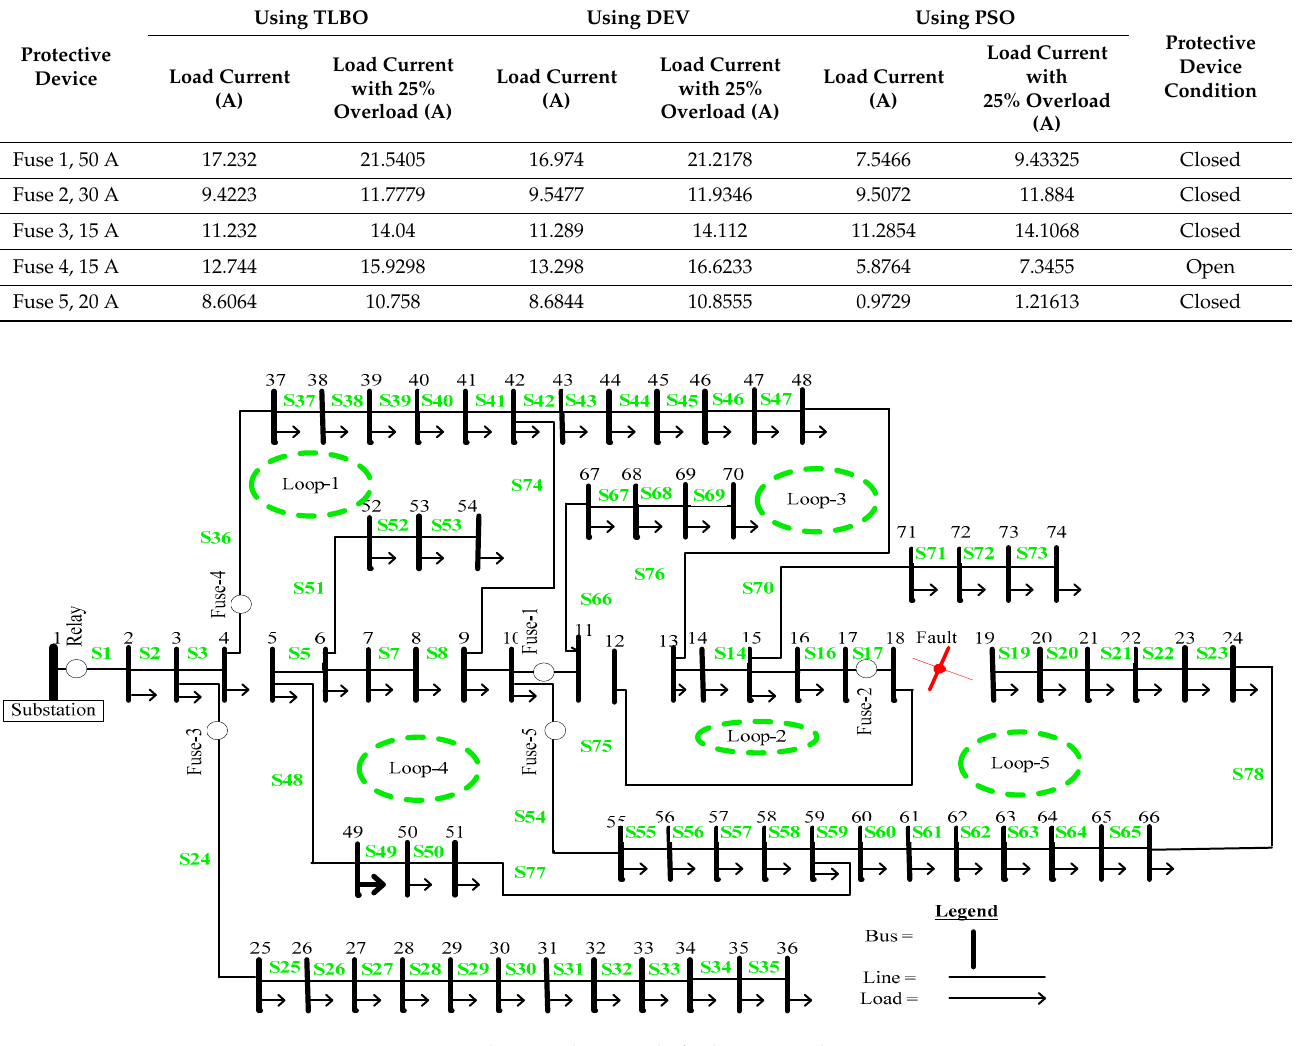
Figure 5. Restored network voltage profile for single fault case using PSO, DEV, and TLBO.